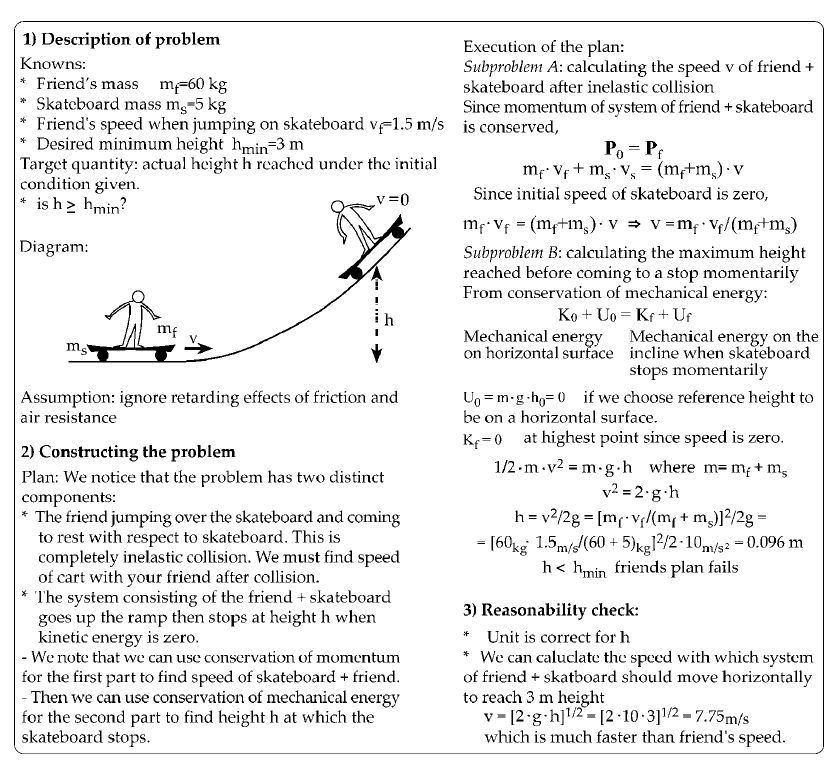
FIG. 5. Worked-out example for the pre problem (quiz 7), aligned with the guidelines.